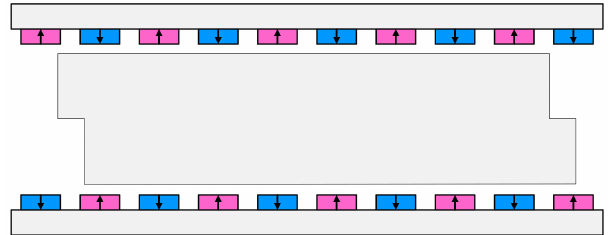
Figure 5. Simulation model of the end force.